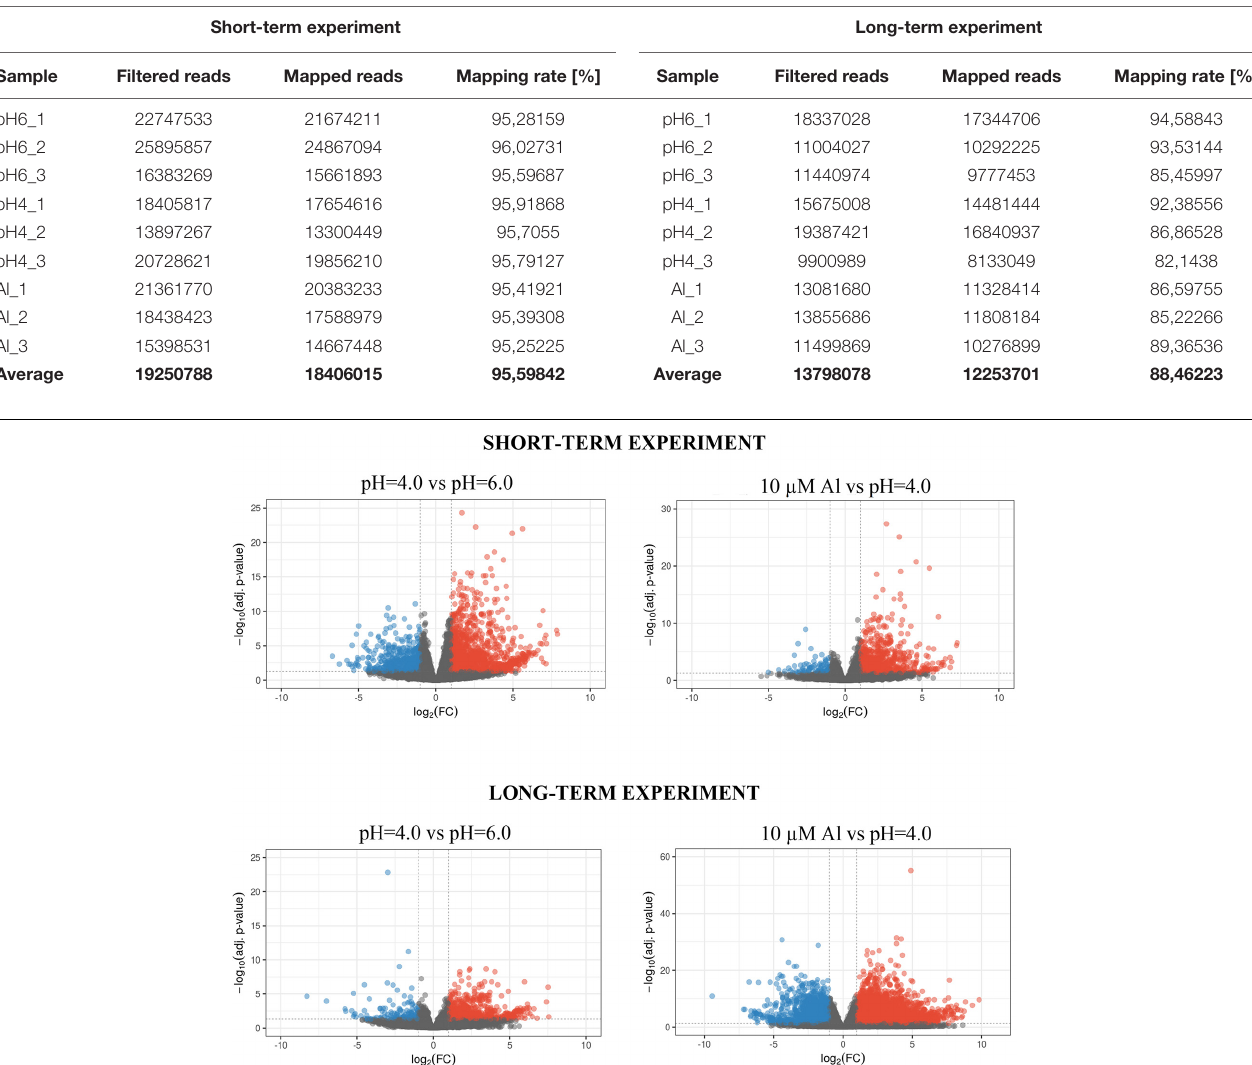
TABLE 1 | The statistics of data filtering and mapping steps for 18 analyzed PE RNA-Seq